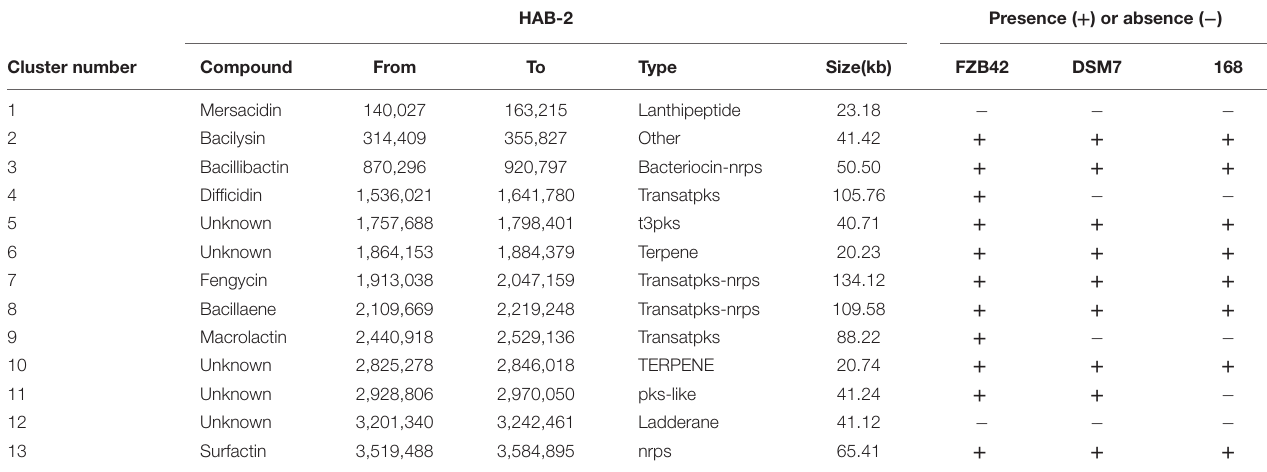
Secondary metabolite antibacterial gene clusters of the four strains were compared and analyzed using anti-SMASH 4.1.0 (Weber et al., 2015).